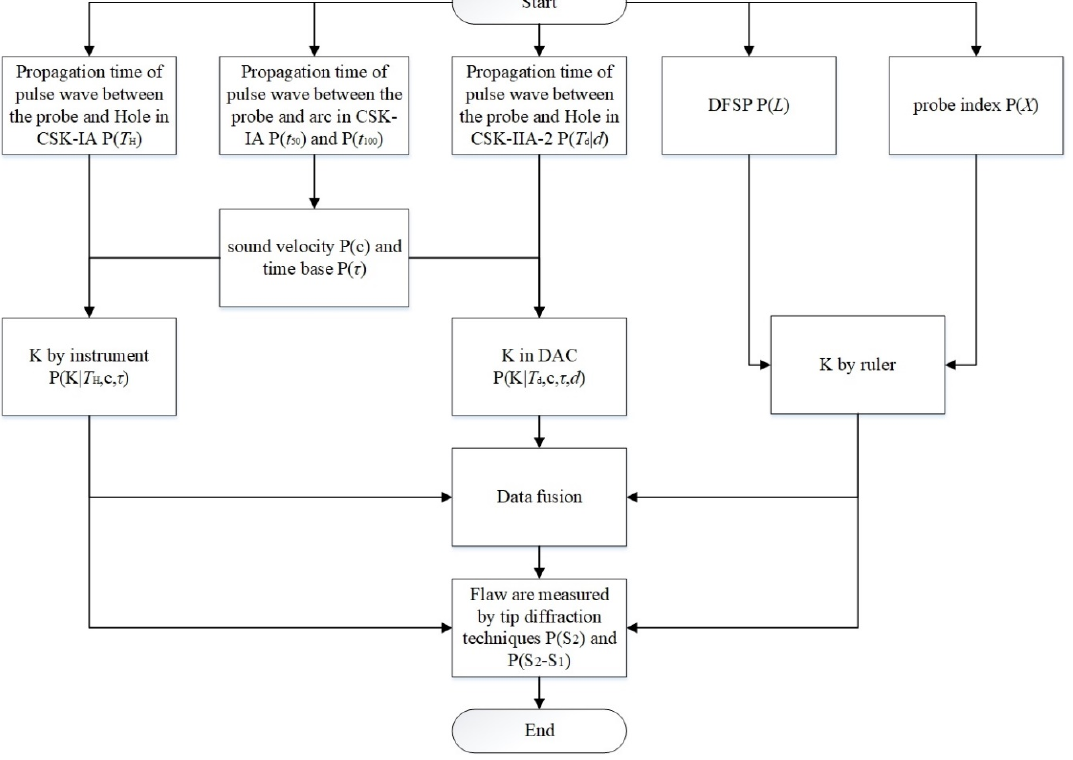
Figure 7. Procedure of Monte Carlo simulation.